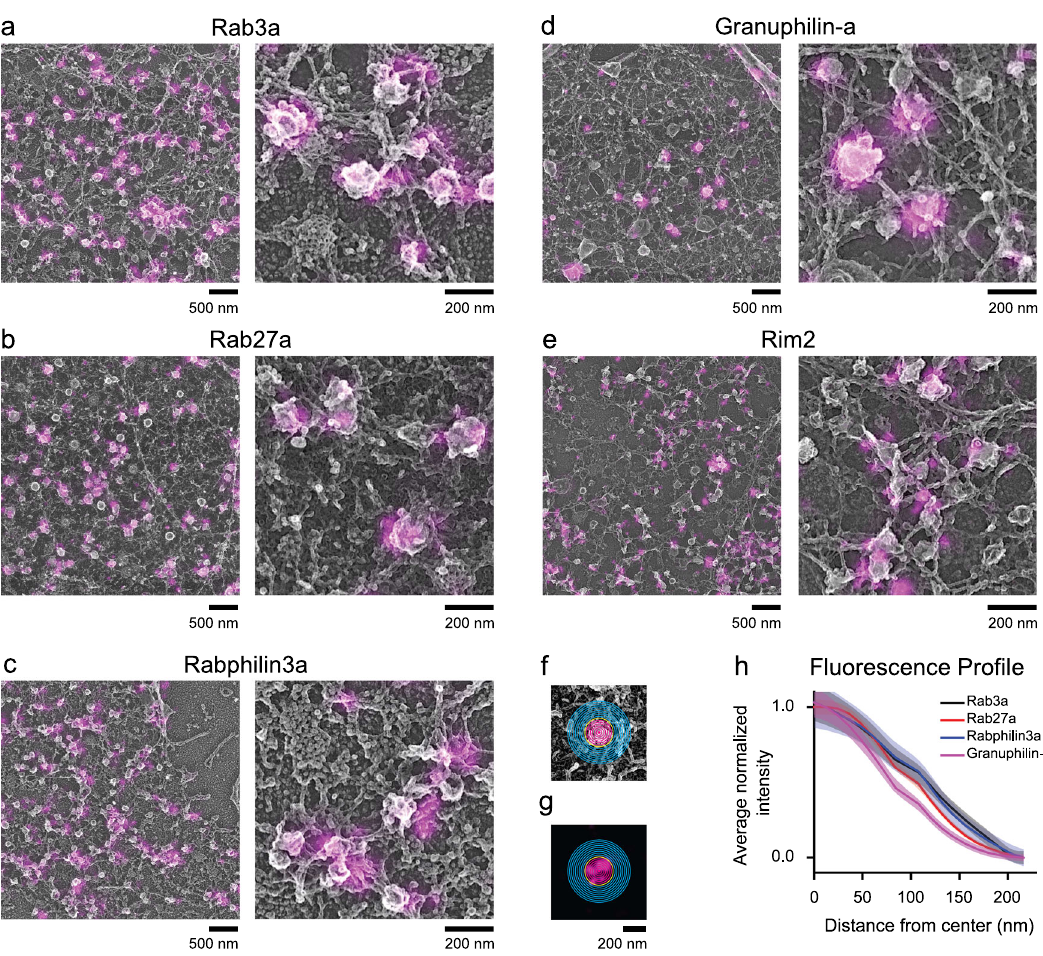
Fig. 2 Correlative dSTORM and platinum replica EM analysis of proteins on DCVs. Correlative images of PC12 cells expressing NPY-mNG and Alexa Fluor-647-GFP-nanobody labeled dark GFP fused proteins a Rab3a, b Rab27a, c Rabphilin3a, and d Granuphilin-a. e Correlative image for endogenous Rim2 labeled with anti-Rim2 antibody. Scale bars are 500 and 200 nm for left and right panels, respectively. Images were cropped from larger images shown in Supplementary Fig. 11. For analysis, ten-pixel-sized bins created from the center of the f EM image and applied to the respective g super-resolved fl uorescent image to plot fl uorescence pro fi les. Yellow circle indicates the outline of vesicle, and pink and blue lines are bins within and outside of the vesicle edge. h Averaged and normalized fl uorescence intensity pro fi les for dGFP-Rab3a ( n = 8 cells; 458 vesicles), dGFP-Rab27a ( n = 7 cells; 545 vesicles), dGFP-Rabphilin3a ( n = 8 cells; 644 vesicles), dGFP-Granuphilin-a ( n = 10 cells; 275 vesicles), and anti-Rim2 ( n = 5 cells; 129 vesicles) (Supplementary Table 1a). Overexpression CLEM data were collected from two (Rab3a, Granuphilin-a) and three (Rab27a, Rabphilin3a) independent experiments and immunolabeled CLEM data from one experiment. The mean fl uorescence intensity is shown as a dark line (black = Rab3a; red = Rab27a; blue = Rabphilin3a; magenta = Granuphilin-a), and the standard error of the mean is shown in transparency. The fl uorescence intensity pro fi les for endogenous proteins including Rab3a, Granuphilin-a, and Rim2 are presented in Supplementary Fig.